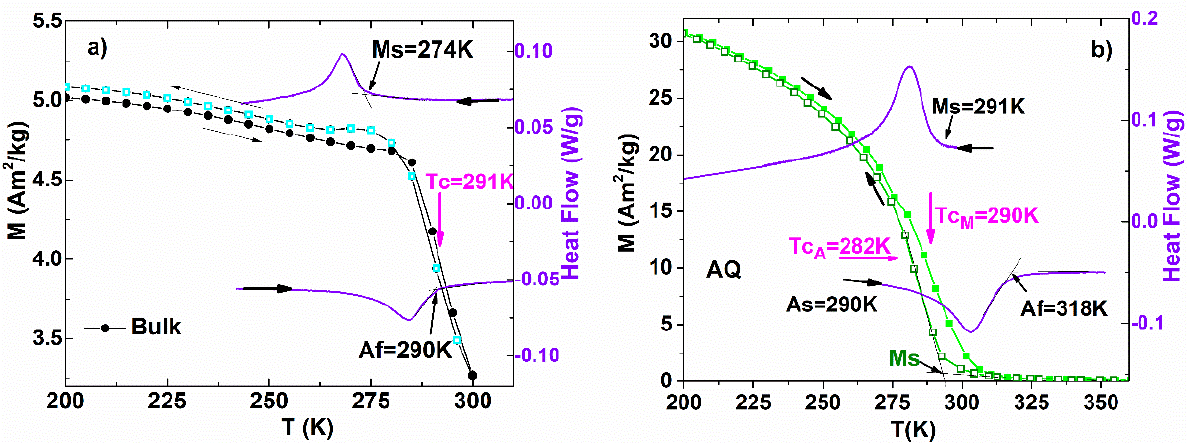
Figure 7. Temperature dependence of magnetization and DSC scans for ( a ) Bulk and ( b ) AQ ribbons.